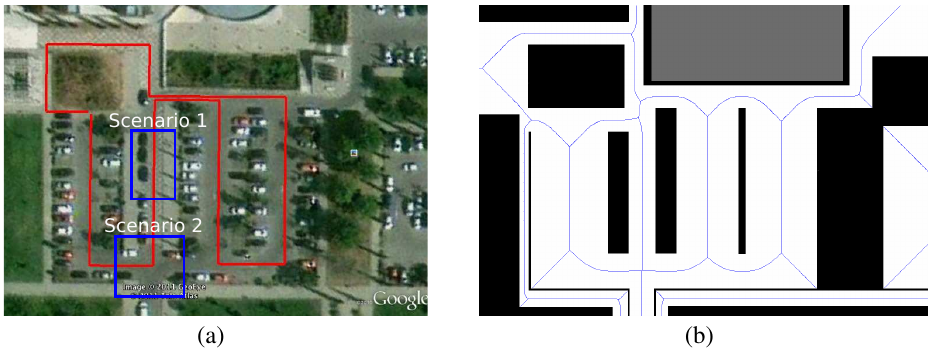
Figure 6. Test environment. ( a ) Surveying route and test scenarios in real environment; ( b )Voronoi